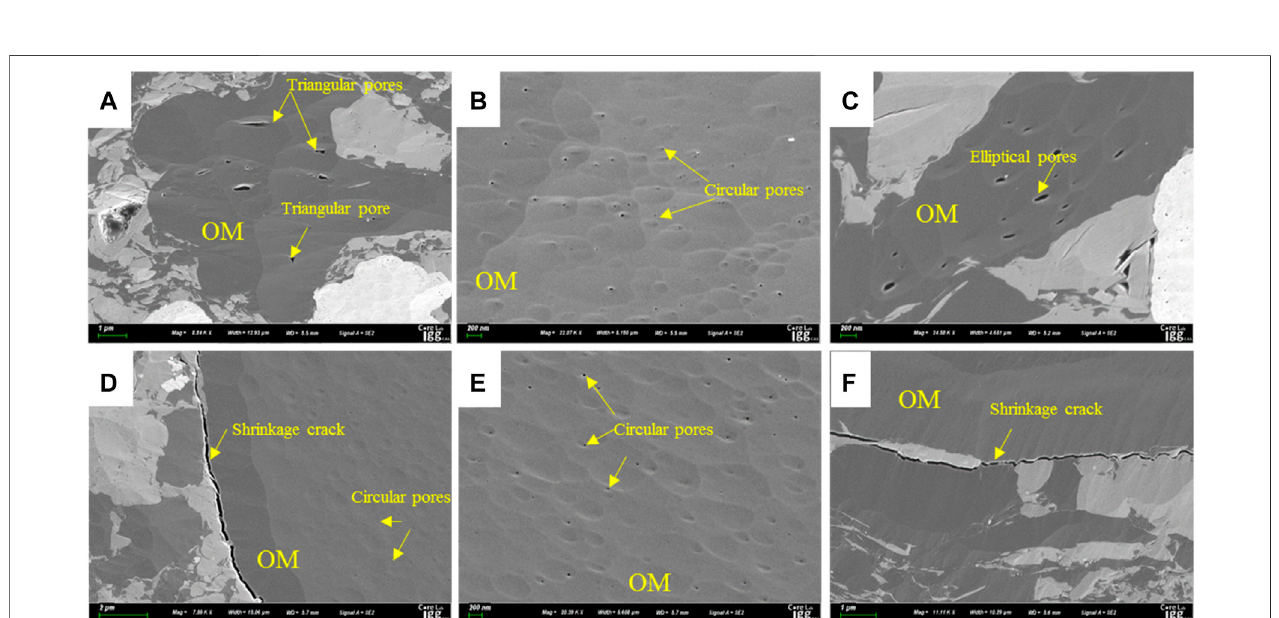
FIGURE 4 | Organic pores in the Shan 23 shale [ (A,B) TOC (cid:1) 14.4%; (C) TOC (cid:1) 32.7%; (D,E) TOC (cid:1) 20.5%; (F) TOC (cid:1) 29.4%].